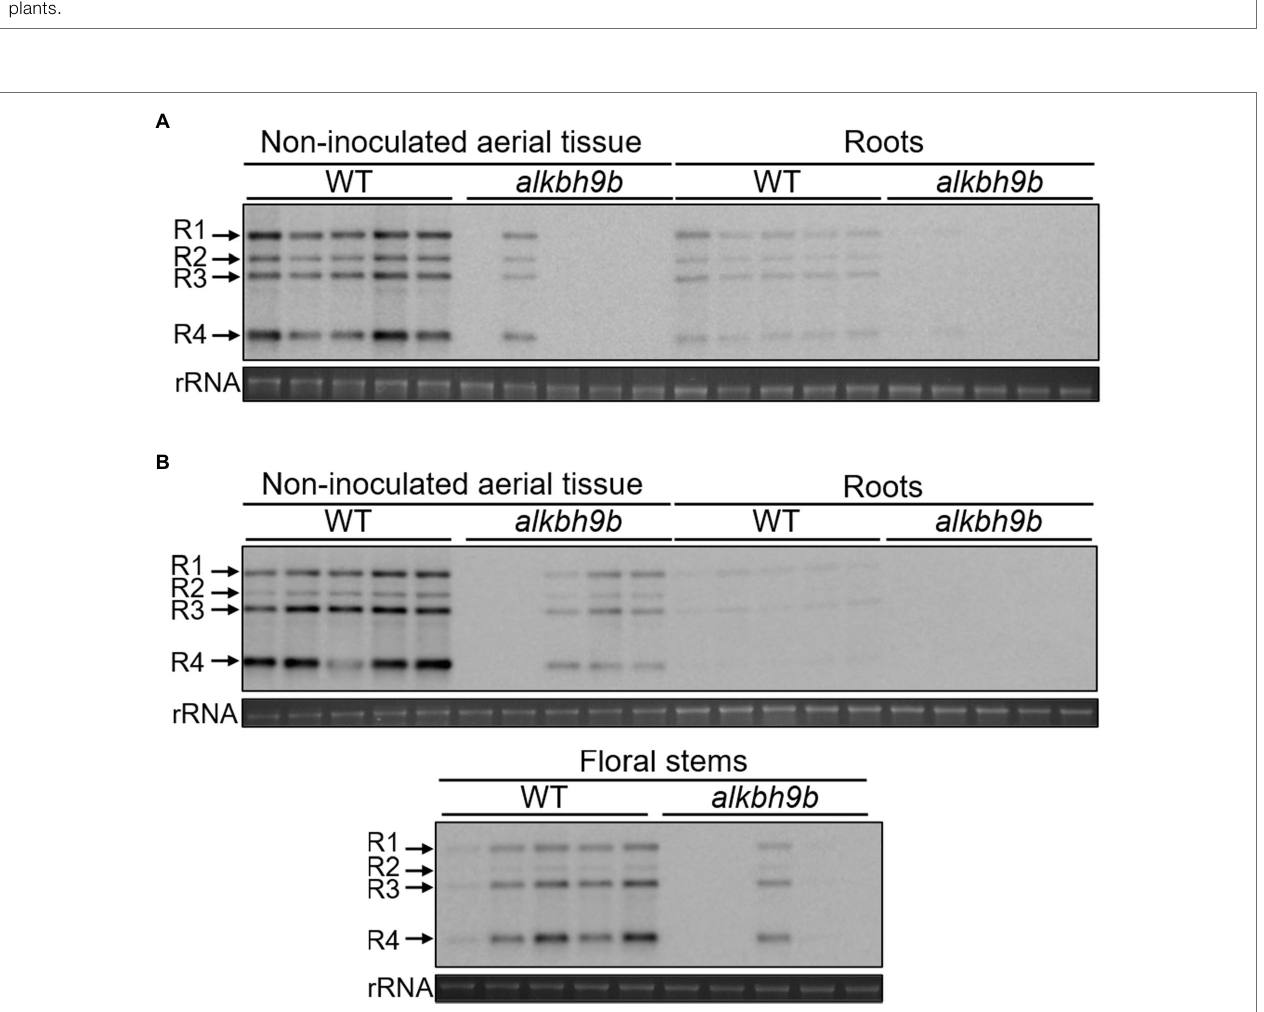
FIGURE 1 | The alignment was obtained with Clustal Omega 1.2.4 with default settings. Asterisks and periods in the consensus line indicate identical and similar residues, respectively. Numbers indicate residue positions. Residues/motifs involved in binding or interactions stabilization in hsALKB5 are highlighted in different colors (see main text). at, Arabidopsis thaliana ; hs, Homo sapiens . (B) Schematic representation of the structure of the ALKBH9A , ALKBH9B, and ALKBH9C genes, with indication of the positions of the T-DNA insertions carried by the alkbh9a , alkbh9b, and alkbh9c mutants. Boxes and lines between boxes represent exons and introns, respectively. Open and black boxes represent untranslated and coding regions, respectively. Triangles represent T-DNA insertions. The oligonucleotides (not drawn to scale) used as RT-PCR and PCR primers are represented as horizontal blue and red arrows, respectively. The following abbreviations are used for oligonucleotide names throughout this figure: LB for LbB1.3; 20F/R for SALK_204823C_F/R; 01F/R for SALK_015591_F/R; 02F/R for SALK_021775_F/R; Lb for LbB1.3a; 9aF/R for qALKBH9a_F/R; 9bF/R for qALKBH9b_Rb; and 9cF/R for qALKBH9c_F/R (see Supplementary Figure Legends ). (C) Genotyping of the insertional single and multiple alkbh9 mutants studied in this work. The presence of the T-DNA insertions shown in (B) was visualized by agarose gel electrophoresis of the PCR amplification products obtained using the primer pairs indicated, one of which is specific to the T-DNA (LB in the figure) and the remaining ones of the disrupted genes. For simplicity, the following non-standard abbreviations are used for genotypes throughout this figure: alkbh9ab for the alkbh9a alkbh9b double mutant; alkbh9ac for alkbh9a alkbh9c ; alkbh9bc for alkbh9b alkbh9c ; and alkbh9abc for the alkbh9a alkbh9b alkbh9c triple mutant. (D) Visualization by agarose gel electrophoresis of the semiquantitative RT-PCR amplification products obtained from ALKBH9A , ALKBH9B , ALKBH9C, and OTC mRNAs. RNA was extracted from plants of the genotypes indicated, some of which are abbreviated as mentioned above. The primers used are also abbreviated as mentioned above. (E–L) Rosettes of (e) the Col-0 WT, the (f) alkbh9a, (g) alkbh9b, and (h) alkbh9c single mutants, the (i) alkbh9a alkbh9b, (j) alkbh9a alkbh9c, and (k) alkbh9b alkbh9c double mutants, and (l) the alkbh9a alkbh9b alkbh9c triple mutant. Photographs were taken 14 days after stratification (das). Scale bars indicate 2 mm. (M) Rosette growth progression of the alkbh9 single and multiple mutants studied in this work. Rosette area was measured for the genotypes indicated at 10, 12, 14, and 16 days after stratification (das). Twelve rosettes were measured per genotype. Asterisks indicate values significantly different from WT (Col-0) in a Student t test ( n = 12; * p < 0.05, ** p < 0.001). Error bars indicate standard deviation. (N) Tissue printing of floral stems from infected plants: WT